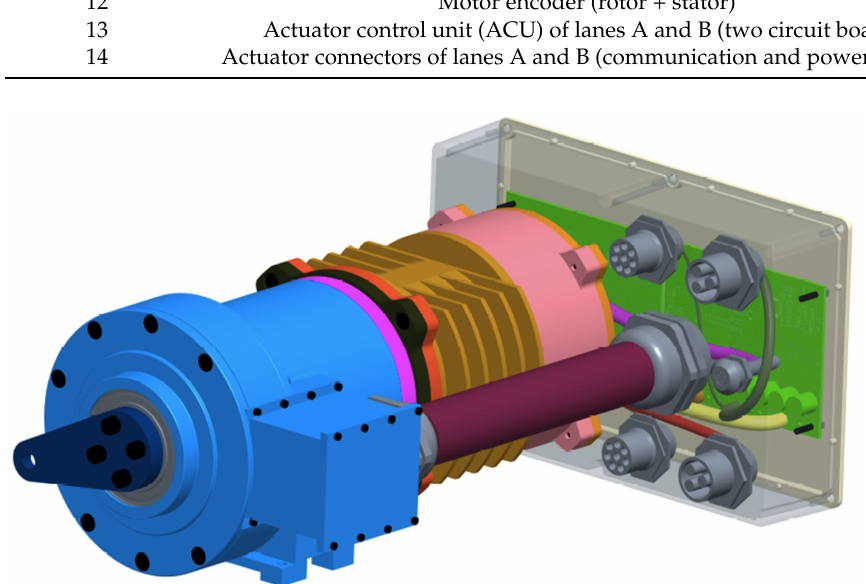
Figure 10. Complete actuator